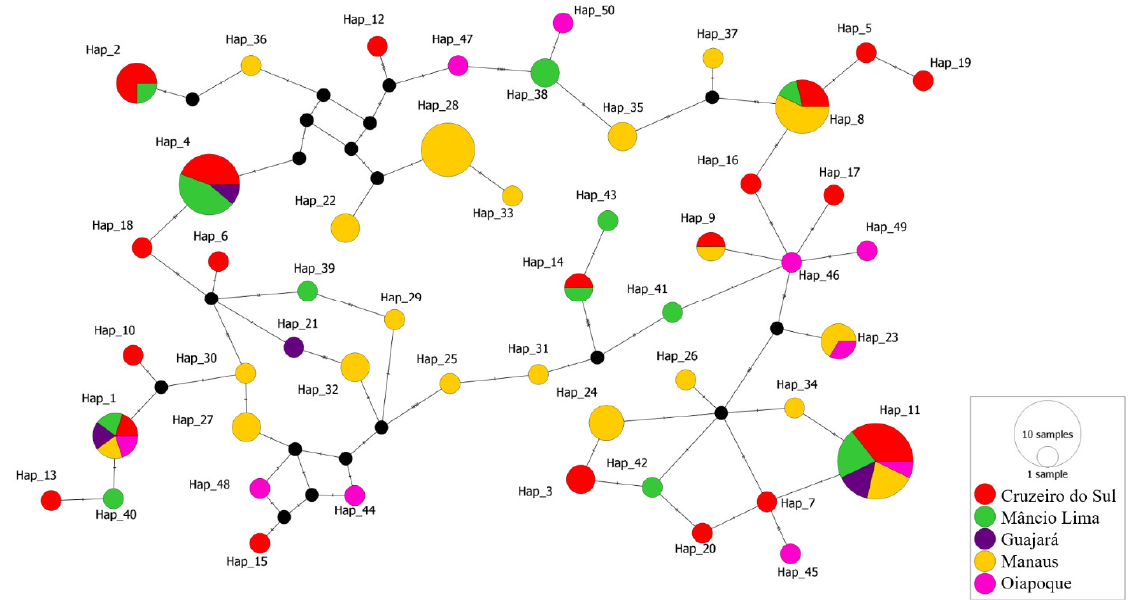
Figure 3. Median-joining network of pvcyrpa haplotypes. Each circle represents a unique haplotype and the color of the circles represents the geographic origins of each haplotype, while the size of the circle represents the frequency of each haplotype. Lines separating haplotypes represent mutational steps.